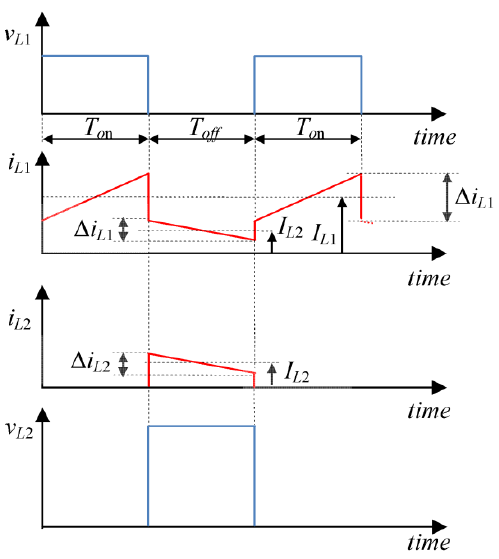
Figure 6. Coupled inductor DC–DC converter in boost mode: voltages and currents.